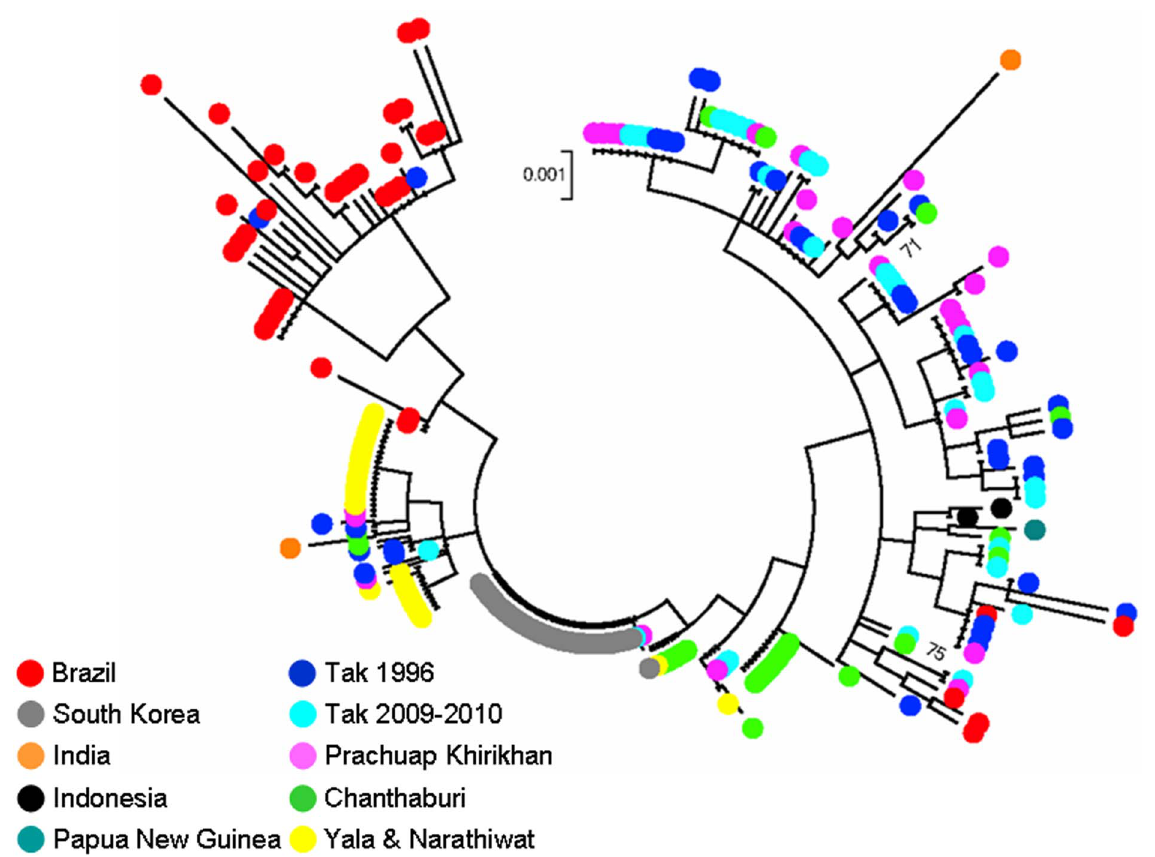
Figure 4. Phylogenetic analysis inferred from a total of 246 PvTRAP sequences from this study and those previously reported [19,28] using the Maximum Likelihood method based on the Tamura 3-parameter model. Gaps and missing data are excluded from analysis. Bootstrap values more than 70% are shown. Dots with different colors represent isolates and their geographic origins as listed on the lower left.